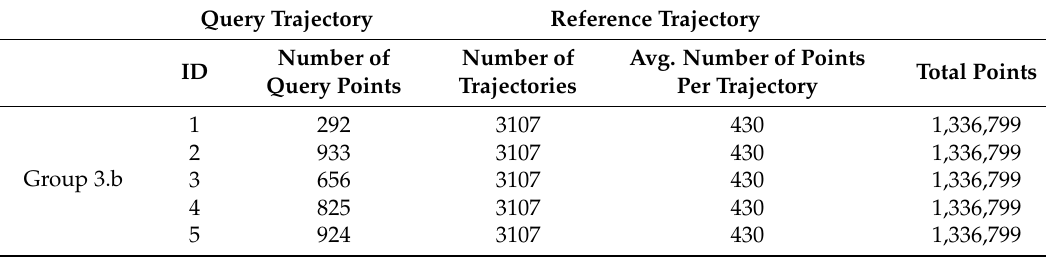
Table A4. Group 3.b